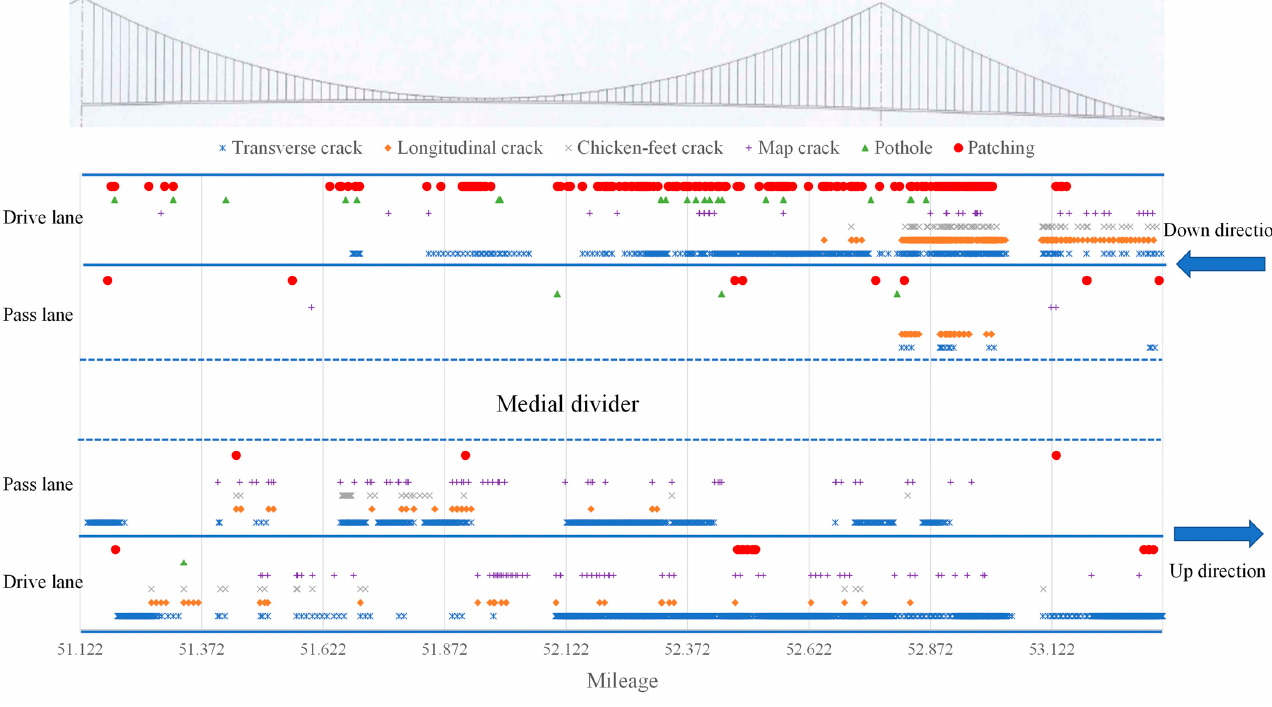
Figure 10. Spatial distribution of XHMB pavement distresses.